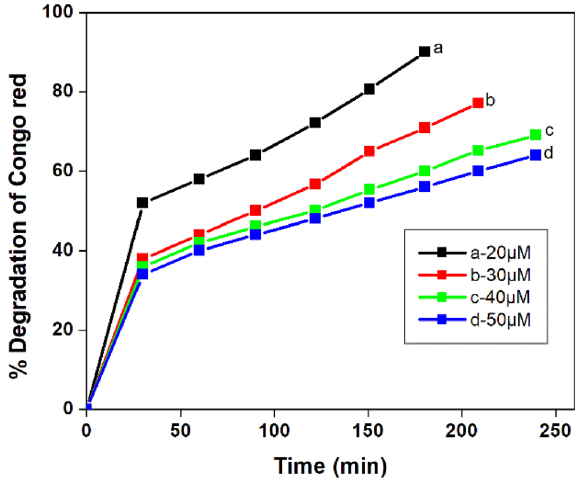
Figure 20. Effect of Initial dye concentration on the photo degradation of Congo red dye solution (pH = 4, NT1 = 0.5 g l −1 ).